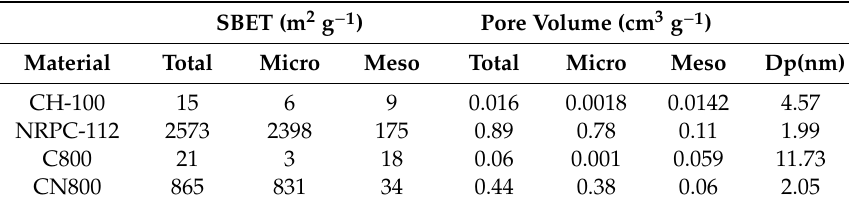
Figure 5. ( a ) N 2 adsorption-desorption isotherm of NRPC-112, ( b ) N 2 adsorption-desorption isotherm of CN800, ( c ) pore width distribution of NRPC-112 obtained by DFT method, ( d ) pore width distribution of CN800 obtained by DFT method. Table 2. Textural parameters of NRPC-112 and